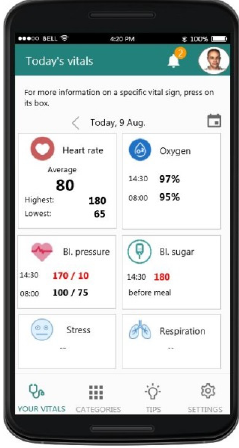
Figure 10. Home screen after expert review. This version was used for the user-based evaluation.